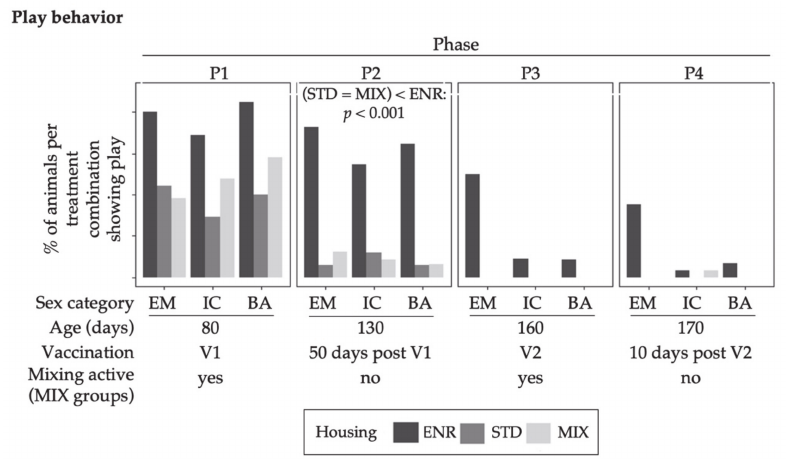
Figure 6. Percentages of animals per treatment combination that demonstrated play behavior at least once when assessed for an hour daily for three observation days. Columns represent the data of animals in four different behavior observation phases (P1–P4). V1 represents phases before, and V2 after the second immunization of IC. The MIX pens were mixed in P1 and P3. Note: no mixing was done in STD and ENR at any time. Sex categories were: EM = entire males, IC = immunocastrates, BA = barrows; Housing environments were: ENR = enriched, STD = standard, MIX = mixing. Housing differences are annotated with p -values in the graphs